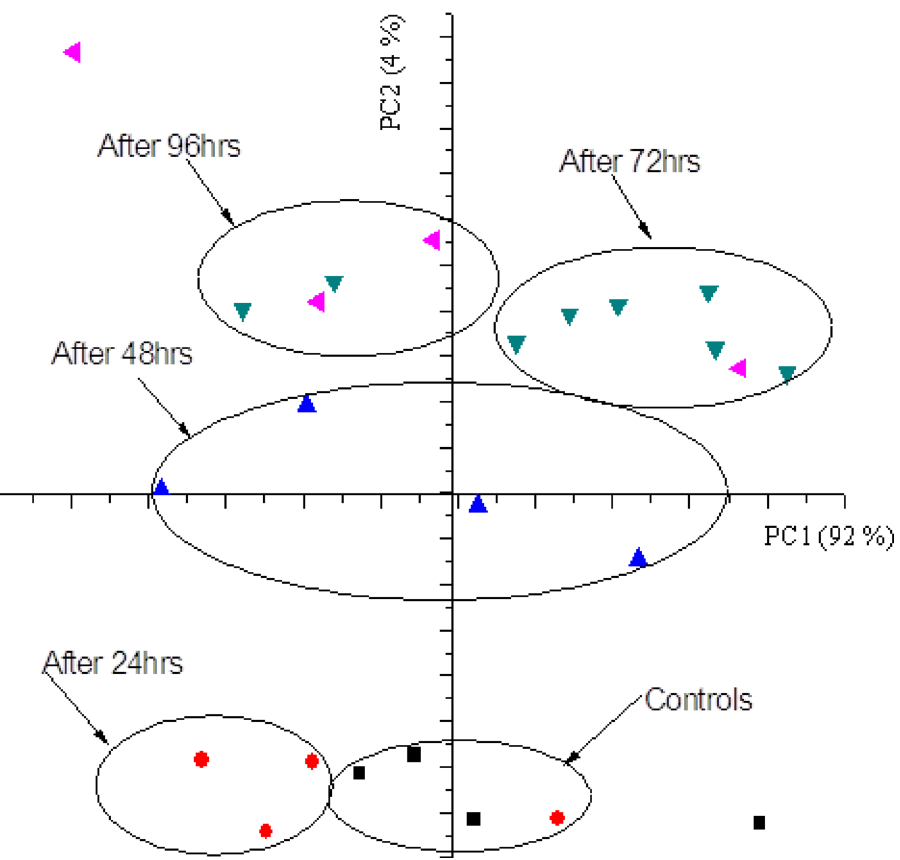
Figure 6. PCA score for cultured blood based on absolute concentrations of the analyzed biometals.